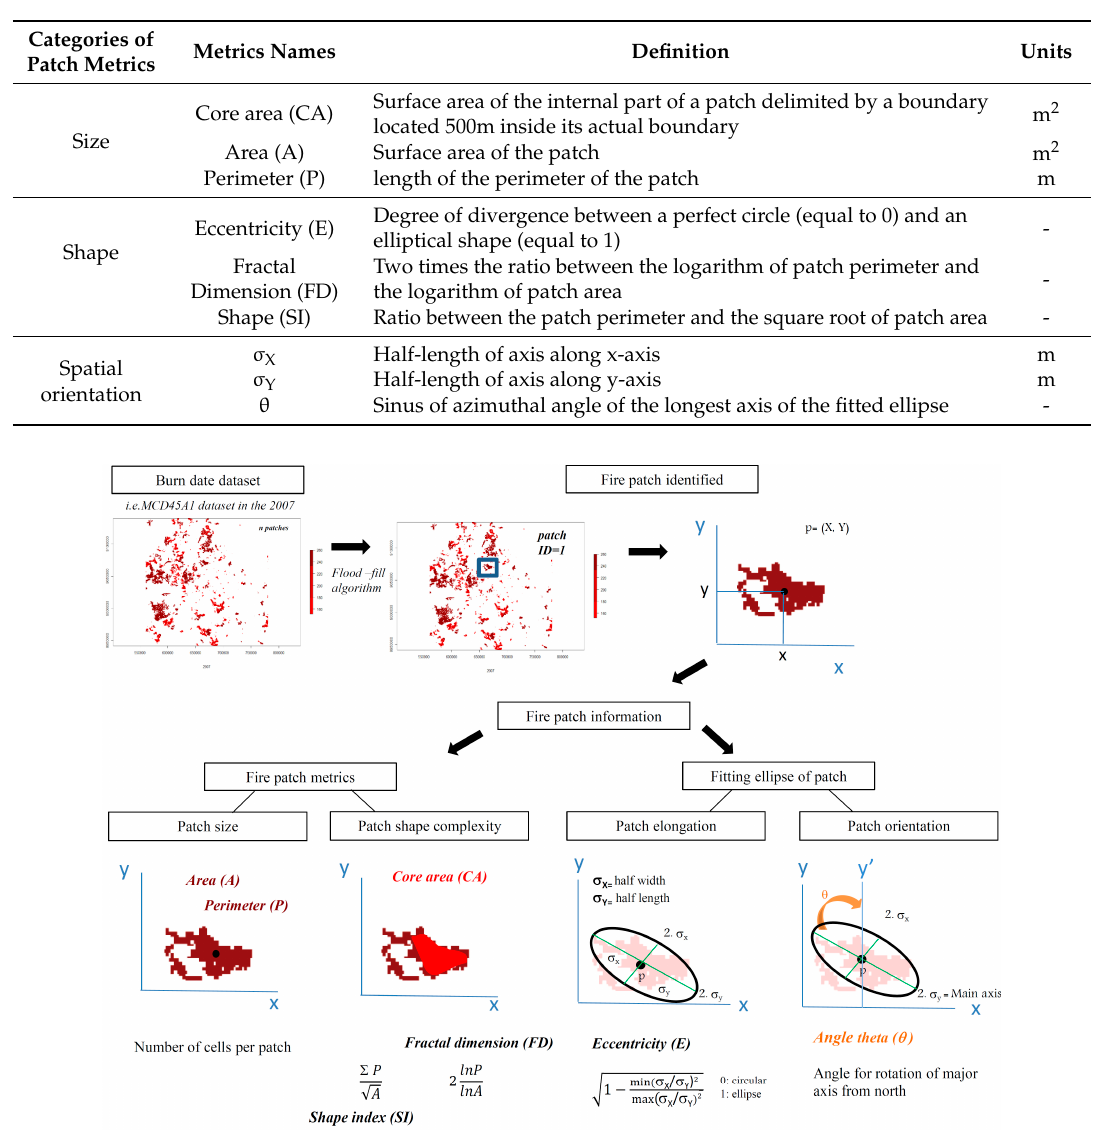
Figure 2. Flowchart of the processing chain of fire patches’ identification and their metrics of size (area A, perimeter P and Core Area CA), shape complexity (shape index SI and fractal dimension FD), elongation (eccentricity E) and orientation (azimuthal angle θ of the longest axis) of the ellipse fitted over the patch.